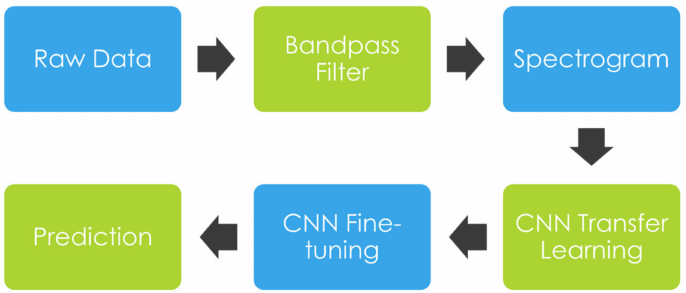
Figure 3. A Diagram of the Process from Pre-processing to